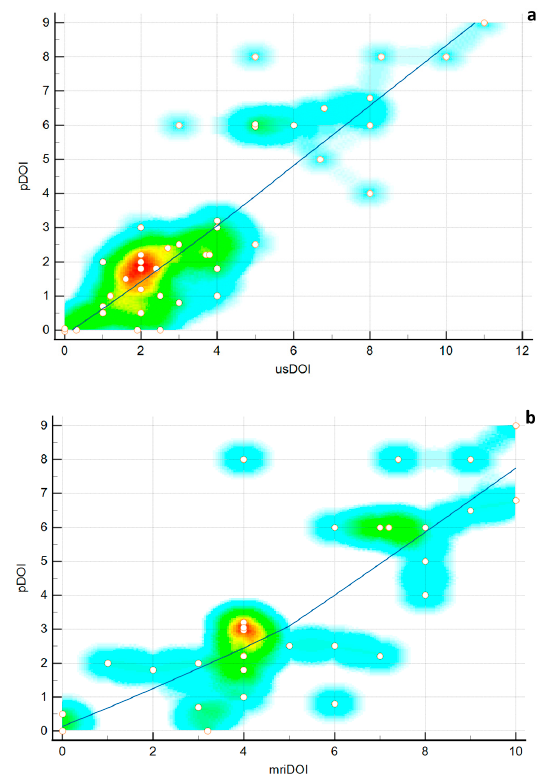
Figure 3. Scatter plots showing the correlation between usDOI and pDOI ( a ) and between mriDOI and pDOI ( b ). Bland–Altman plots between the usDOI and pDOI, mriDOI and pDOI, and usDOI and mriDOI are shown in Figure 4a, 4b, and 4c, respectively. The mean bias between the usDOI and pDOI was 0.7 mm (95% CI 0.26–1.16), whereas the bias between the mriDOI and pDOI was 1.6 mm (95% CI 1.56–1.90). The mean bias between the usDOI and mriDOI was − 0.7 mm (95% CI − 1.24–0.24). The null hypothesis that there is no correlation between the usT stage and pT stage was rejected, and the alternative hypothesis that there is a relation between the two clas- sifications was accepted ( p < 0.0001) (Figure 5). The sensitivity and specificity for the IOUS to predict a pDOI ≥ 4 mm were 92.31% and 82.14%, respectively. The area under the ROC curve (AUC) was 0.87 (95% CI 0.73–0.95, p < 0.0001) (Figure 6). Using the IOUS, we found that 39 tumors went beyond the epithelial layer and infil- trated the subepithelial connective tissue, while 3 did not. Upon a histological examina- tion, we found that 36 tumors were invasive while 5 were in situ. The specificity, sensitiv- ity, negative predictive value (NPV), and positive predictive value (PPV) for the IOUS to predict an invasive cancer were 100%, 94.7%, 60%, and 100%, respectively. The AUC was 0.8 (95% CI 0.646–0.908, p < 0.0001) (Figure 6).